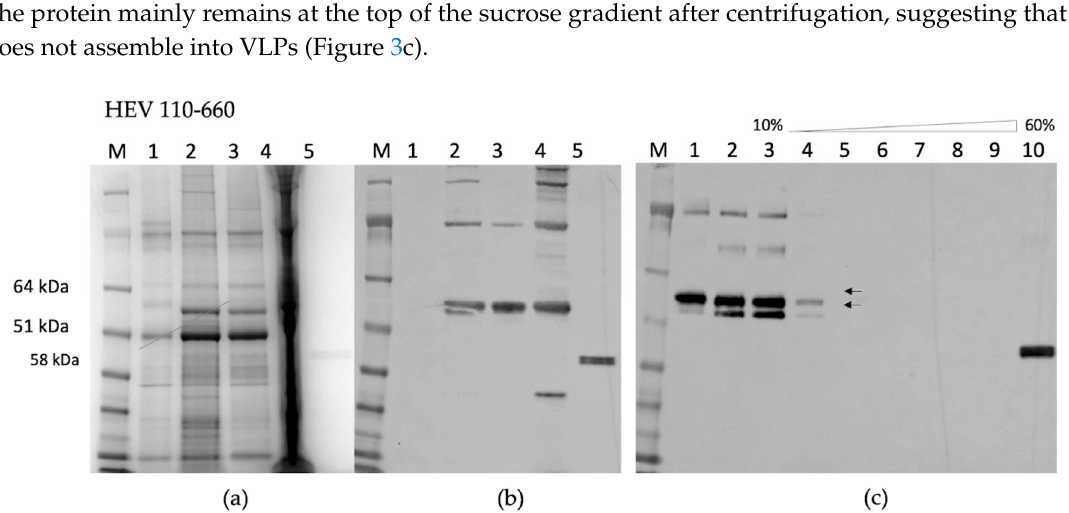
Figure 3. ( a ) SDS-PAGE of HEV 110–660; M. Molecular weight marker (kDa); 1. pEAQ- HT empty vector; 2. Crude extract; 3. SN (soluble protein) after extraction in 3× volume extraction buffer and 13k rpm; 4. Pellet (insoluble part); 5. Positive control (HEV ORF2 452–617 aa recombinant protein) ( b ) Western blot with anti-HEV ORF2 mAb, the samples are in the same order; ( c ) Sucrose gradient; M. Molecular weight marker (kDa); 1. SN after pelleting; 2. Dissolved pellet from gradient; 3. 10% sucrose; 4. 20%; 5. 30%; 6. 40%; 7. 50%; 8. 60%; 9. Pellet; 10. Positive control (HEV OF2 452–617 aa recombinant protein).